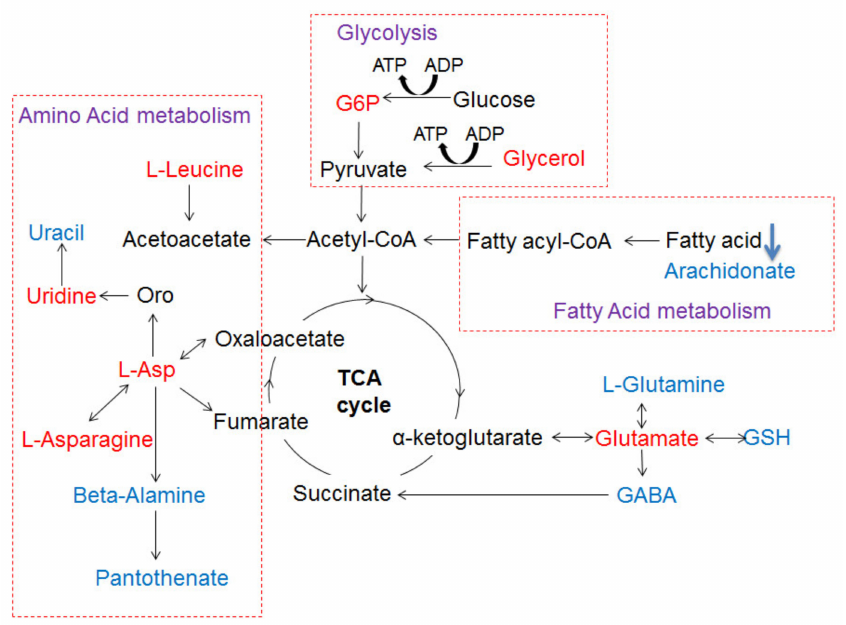
Figure 7. The Schematic sketch of pathway analysis based on differentially produced metabolites identified in liver. Red color and blue color denote up-regulated and down-regulated,